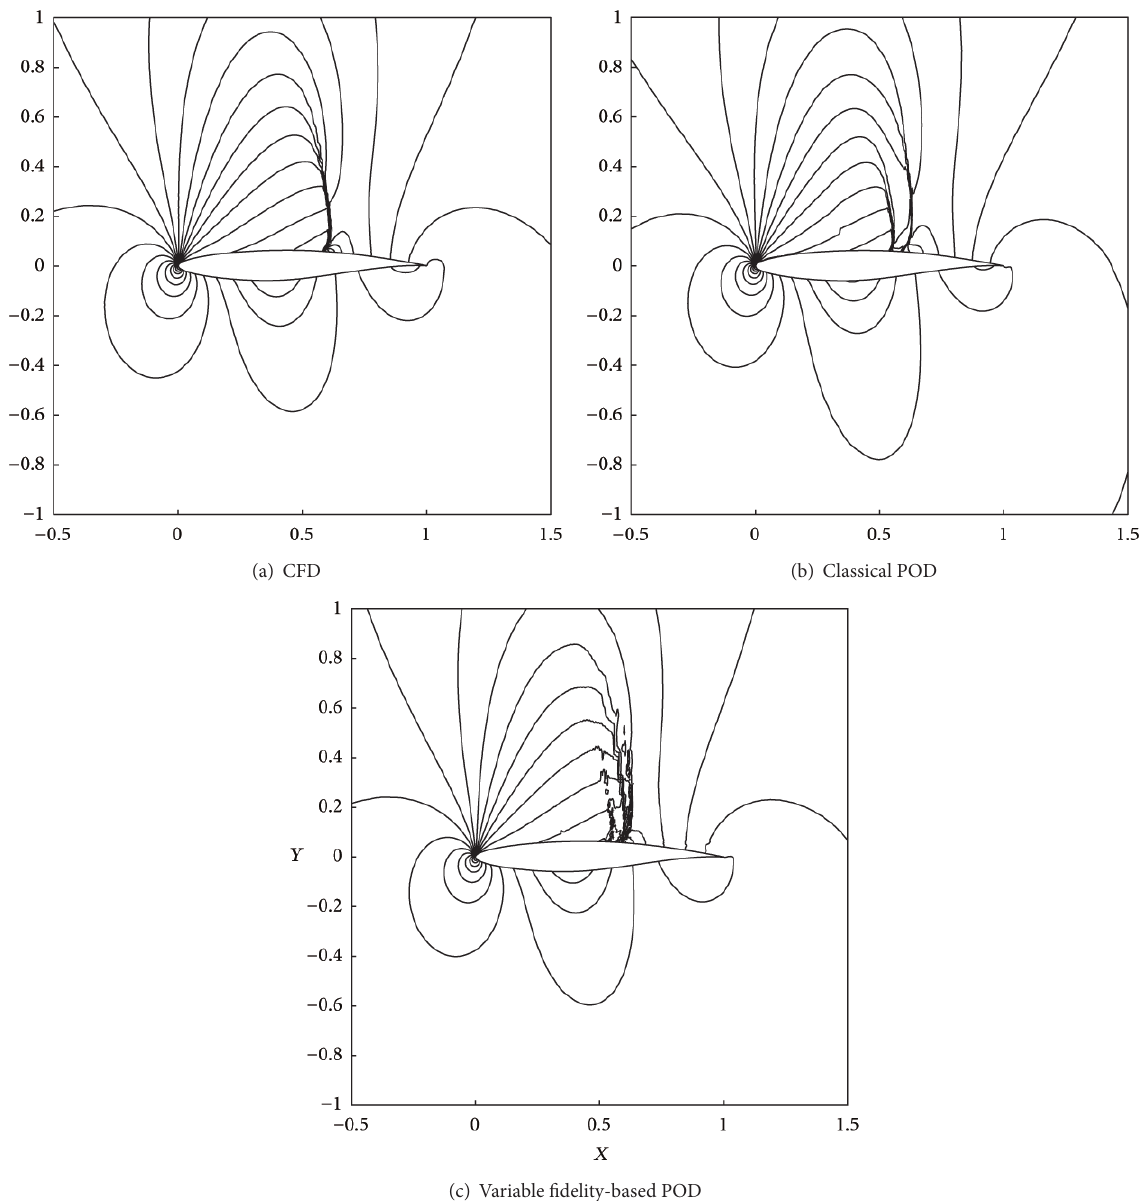
Figure 7: Comparison of the 3 contours of pressure at Mach = 0.7375 and A . O . A . = 3.125